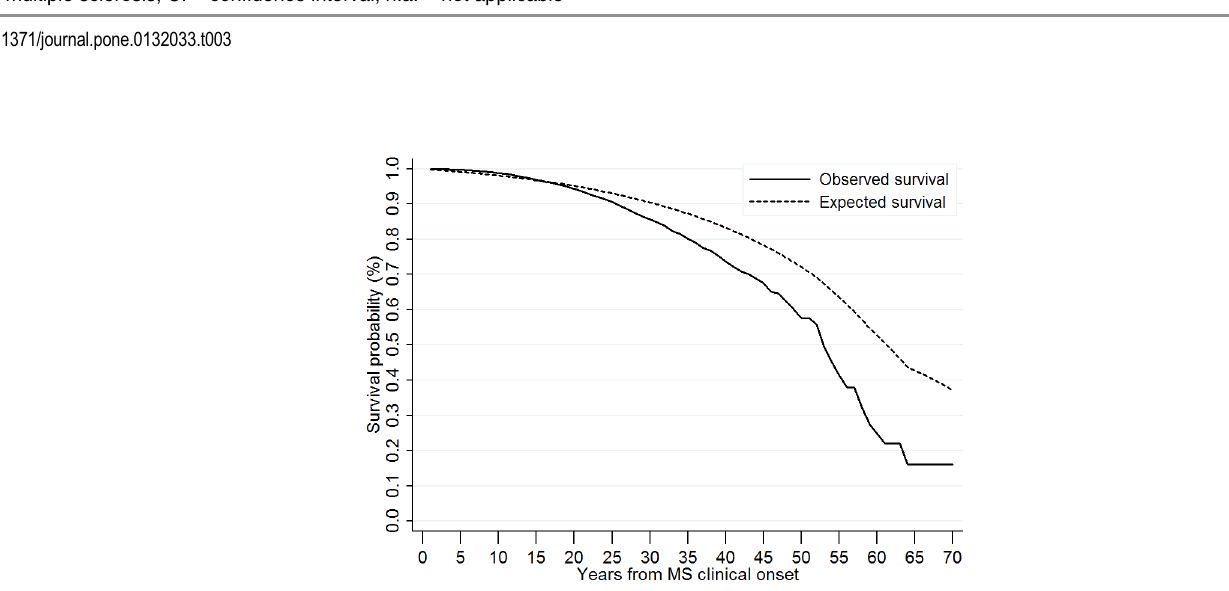
Fig 2. Comparison of the survival in MS patients with the survival of the French general population. Kaplan-Meier survival estimates according to time from MS clinical onset (years). MS = Multiple Sclerosis.